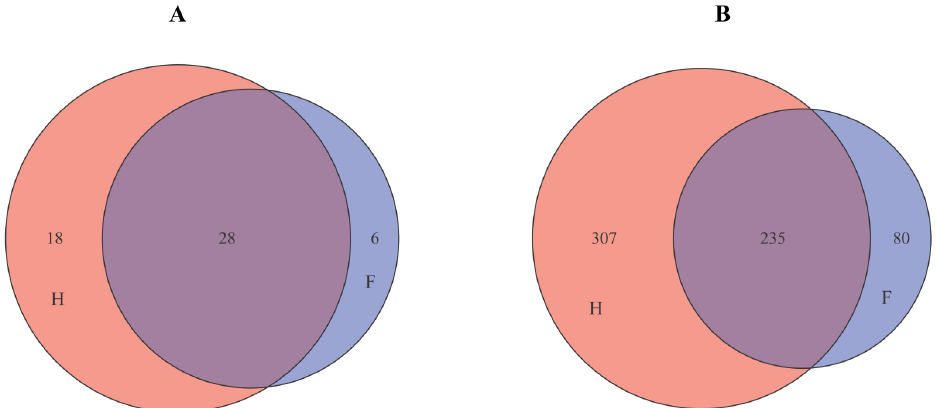
Figure 4. Venn diagram ( A ) is based on phylum level; ( B ) Based on genus level. F means factory production; H means household handmade. Orange stands for group H, blue stands for group F, and purple stands for both groups.